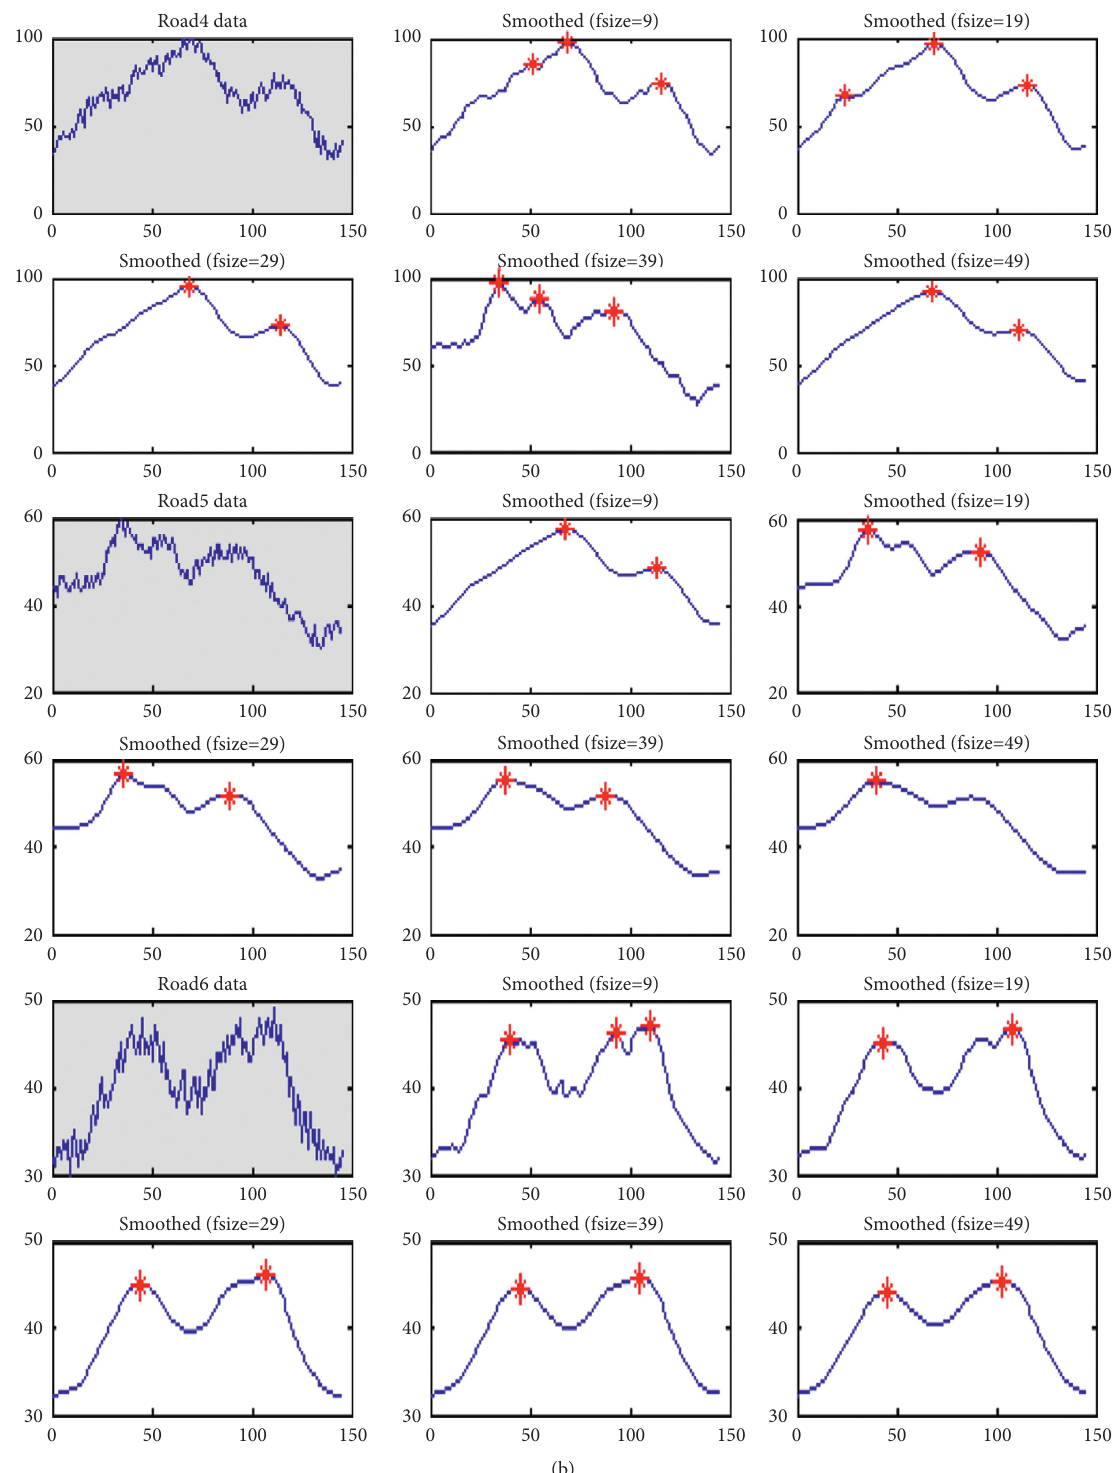
Figure 16: The data smoothed by Gaussian filter and the peaks